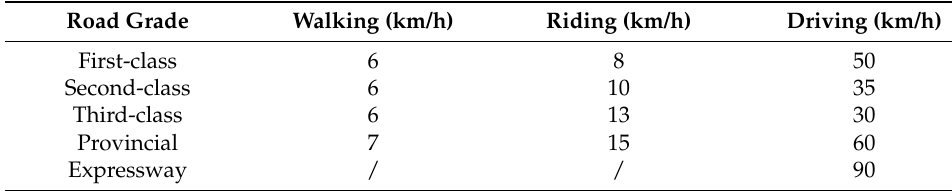
Table 2. The speed table for each commuting mode in different grades of road. Road Grade Walking (km/h) Riding (km/h) Driving